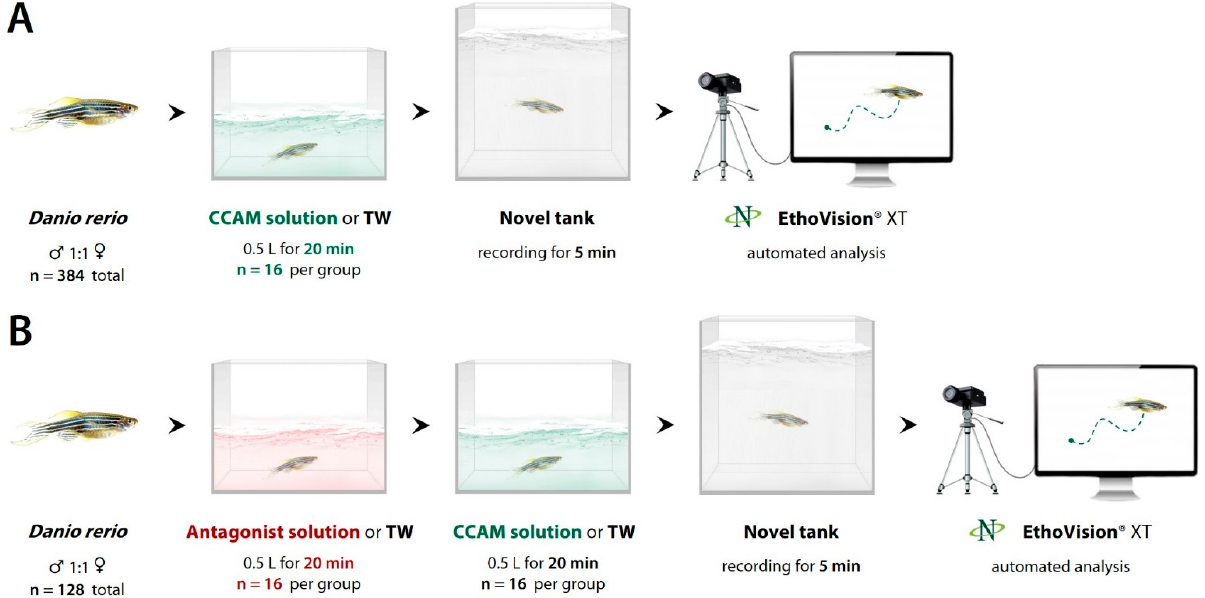
Figure 1. Design of Experiments 1–5 and 8 ( A ) and Experiments 6 and 7 ( B ). CCAM, chromone- containing allylmorpholine; TW, tank water.